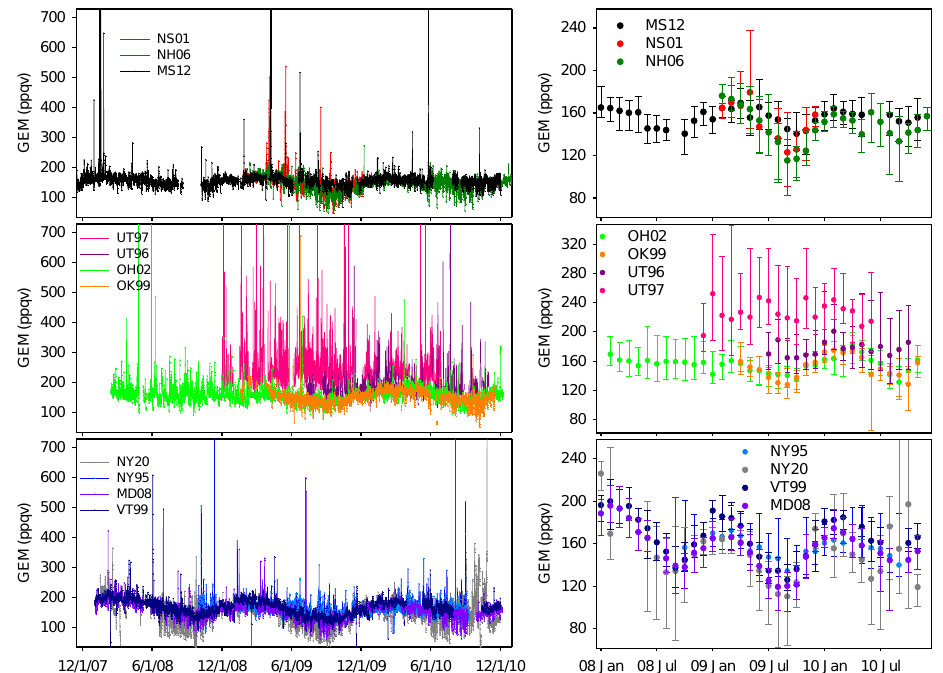
Fig. 2. Complete time series of GEM (left panel) and the monthly median mixing ratio at 11 sites. The upper error bars represent 90 percentile while the lower error bars represent 10 percentile values (right panel).